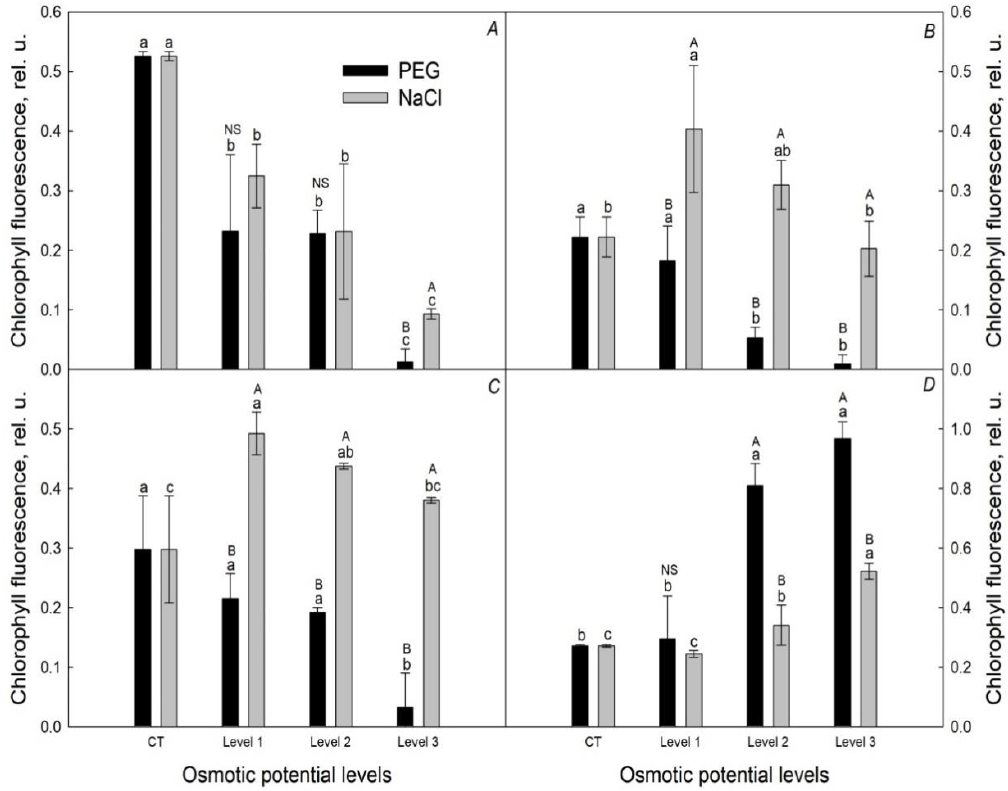
Figure 3. Means ± SD (n = 3) of the e ff ective quantum yield of photosystem II under illumination ( Φ PSII ) ( A ) non-photochemical quenching (NPQ); ( B ) quantum yield of regulated energy dissipation of photosystem II [Y(NPQ)]; ( C ) quantum yield of non-regulated energy dissipation of photosystem II [Y(NO)]; ( D ) of leaves collected from seedlings grown under three iso-osmotic potential levels with separate PEG and NaCl treatments. Level 1: 24% ( w / v ) PEG and 200 mM NaCl; Level 2: 26.5% ( w / v ) PEG and 250 mM NaCl; Level 3: 29% ( w / v ) PEG and 300 mM NaCl. Means with di ff erent lowercase letters significantly di ff er in an LSD test under di ff erent PEG or NaCl concentrations, respectively ( p < 0.05). Means with di ff erent capital letters significantly di ff er in a t -test between PEG and NaCl concentration at the same osmotic potential level.